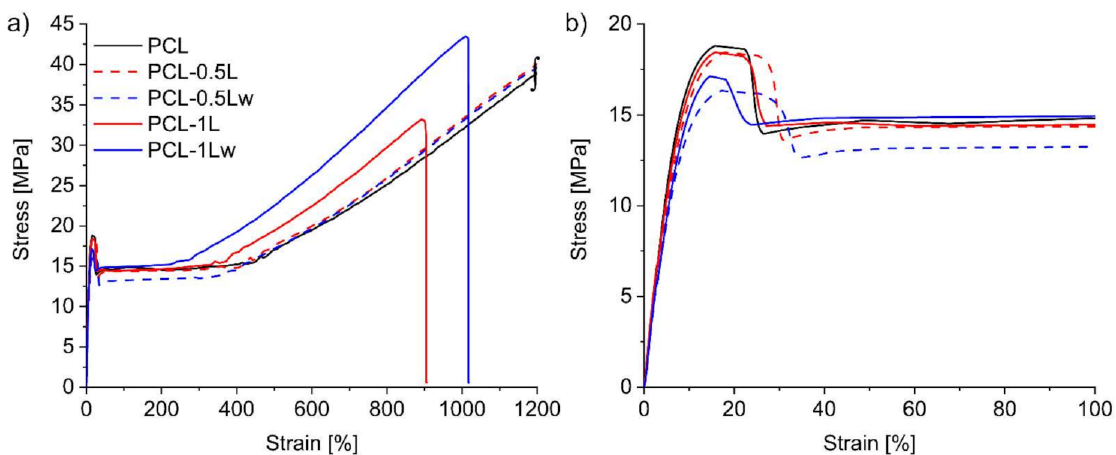
Figure 5. ( a ) Stress-strain curves from tensile tests at room temperature of neat and reacted PCL and ( b ) their magnification on the yield